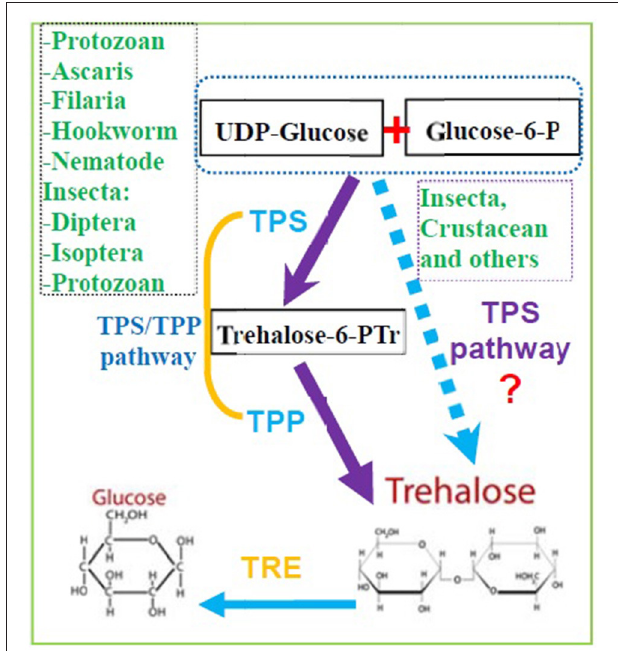
FIGURE 2 | The potential pathway of trehalose synthesis in insects and other invertebrate animals. Trehalose are mainly synthesized by the pathway of TPS and TPP in many kind of invertebrates, but it also be synthesis by TPS only in some species from Insecta and Crustacean. (TPS, Trehalose-6-phosphate synthase; TPP, Trehalose-6-phophate phosphatase; TRE,